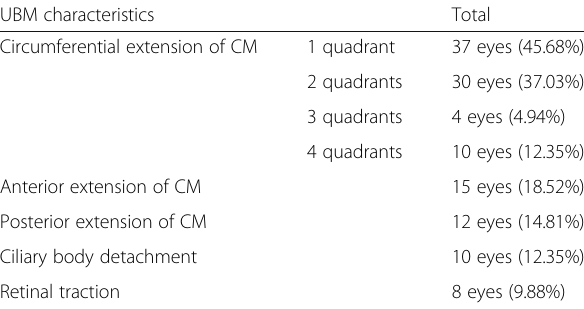
Table 2 UBM characteristics of cyclitic membranes and